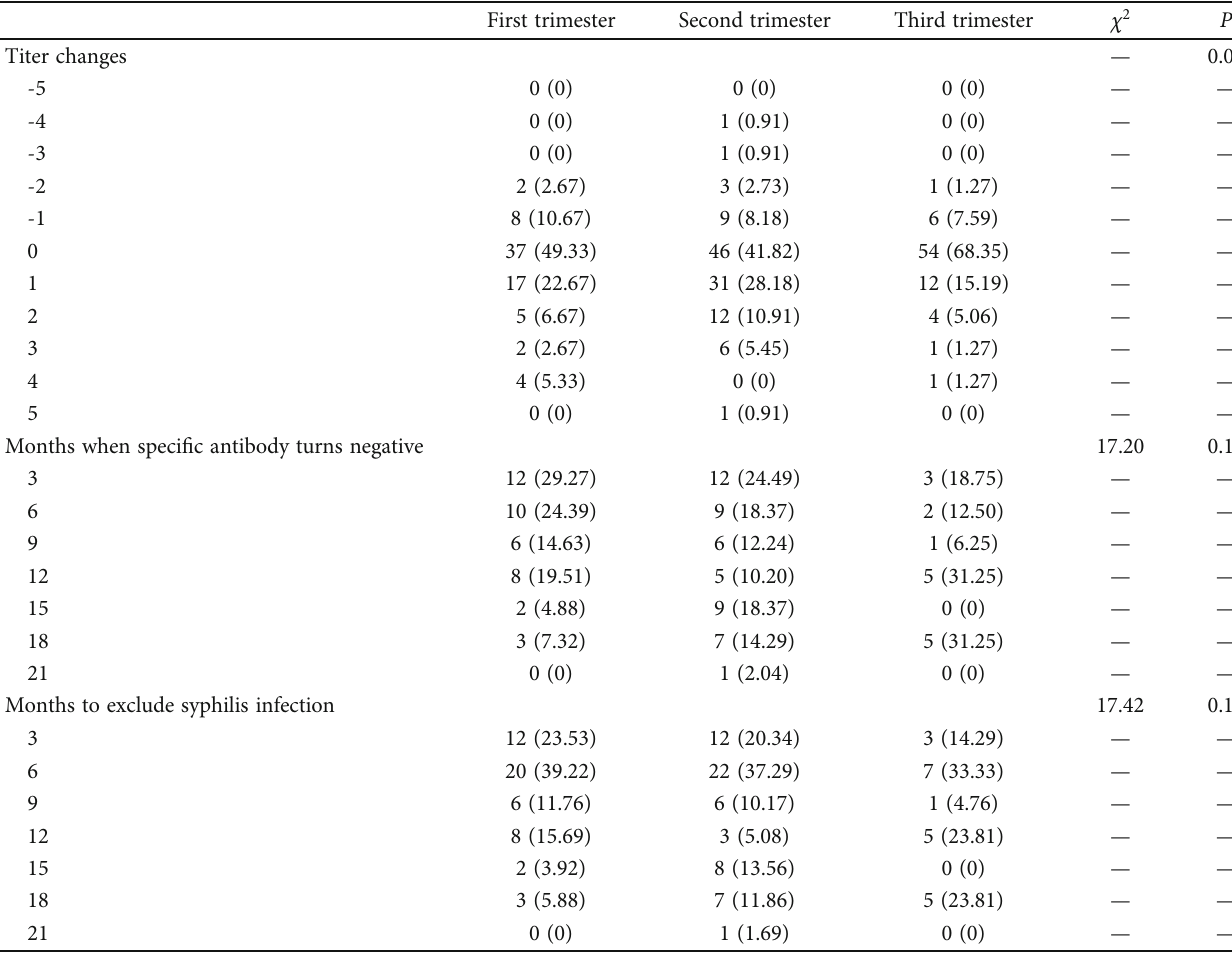
Table 6: Comparison of results features of one course of treatment at di ff erent stages of